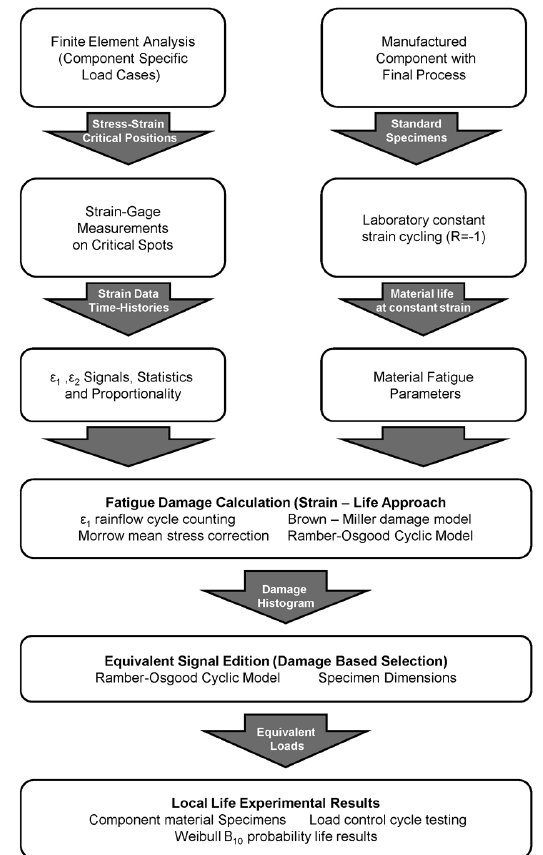
Figure 1. Proposed methodology